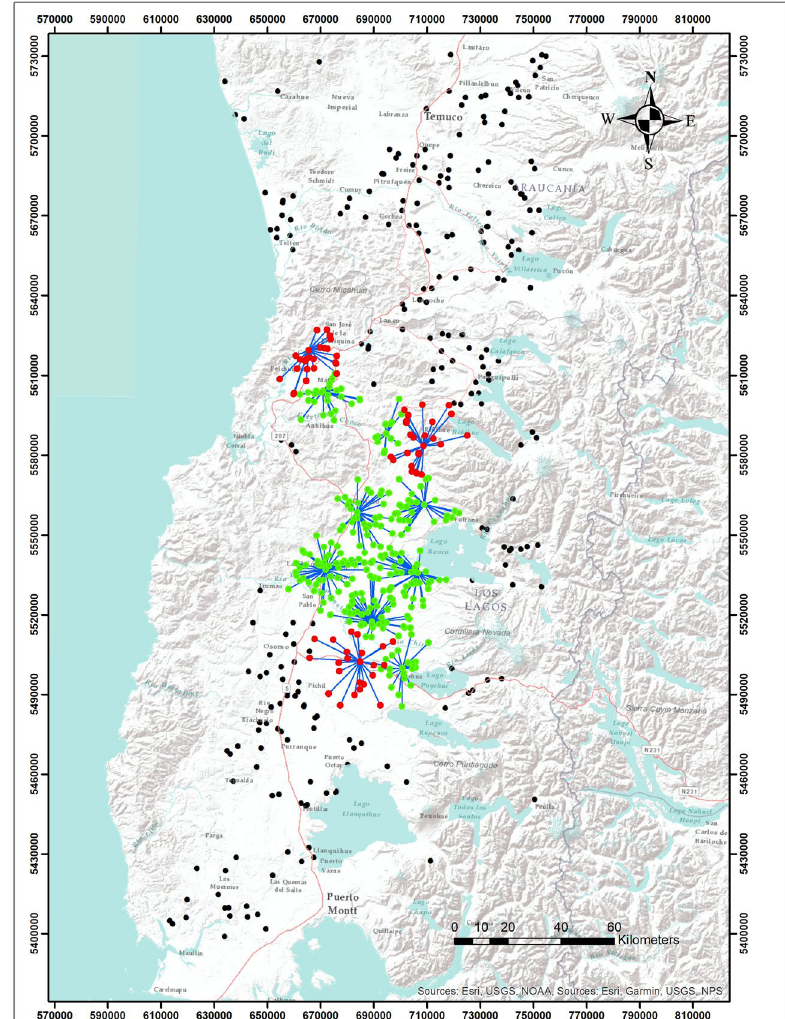
Fig. 4 Plant locations accord- ing ArcGIS Network Analyst with a maximum radius of up to 25 km, in the most profit- able